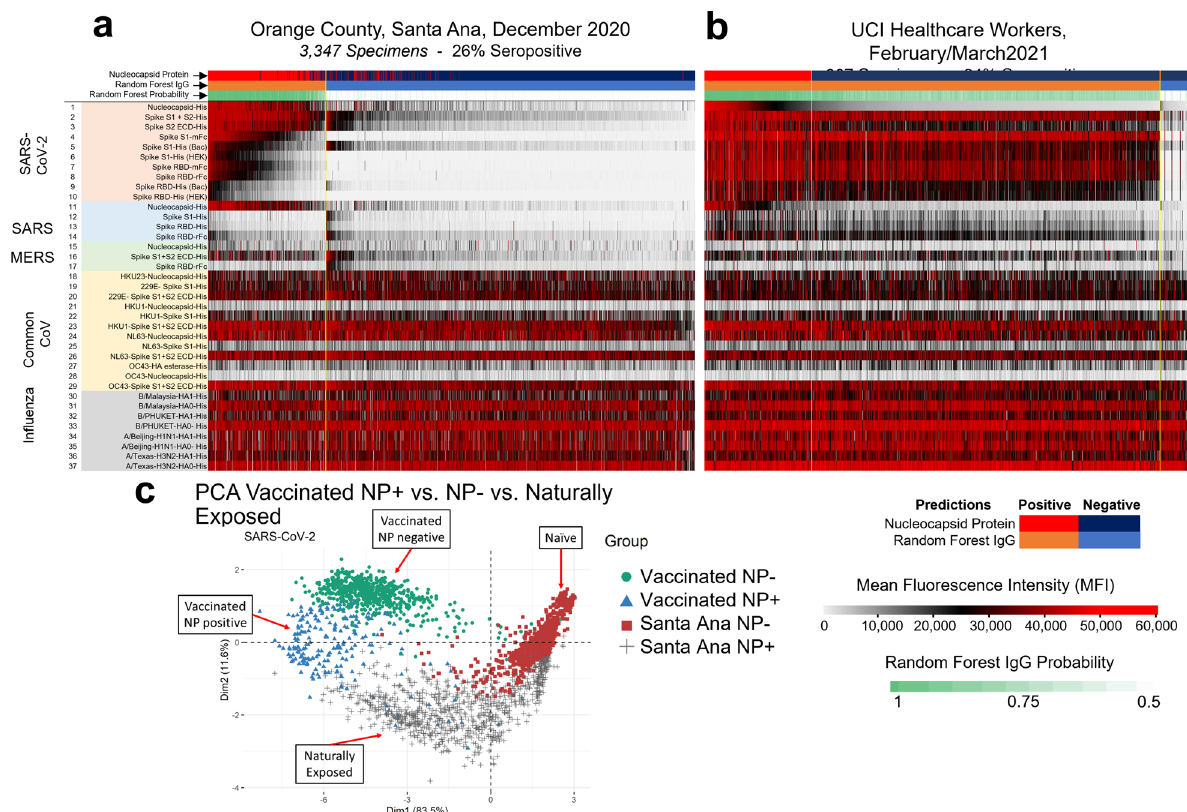
Fig. 3 Antibody reactivity of the Santa Ana and health care workers groups. The heat maps show all of the IgG reactivity data from 3347 pre-vaccination specimens collected from Santa Ana in December 2020 ( a ), and 907 post-vaccination specimens collected from the UCIMC in February ( b ). The 37 antigens are in rows and the specimens are in 3347 columns for ( a ) and 907 columns for ( b ). The level of antibody measured in each specimen against each antigen is recorded as mean fl uorescence intensity (MFI) according to the graduated scale from 0 to 60,000. Red is a high level, white a low level and black is in between. a Samples are classi fi ed as either SARS-CoV-2 seropositive clustered to the left (orange bar) or seronegative and clustered to the right (blue bar). Seropositive specimens recognize nucleoprotein and full-length spike. RBD segments are recognized less well. b Reactivity of specimens from 907 UCIMC HCW, 94% were vaccinated and seropositive. The heatmap shows that seropositive vaccinees in the HCW cohort can be classi fi ed into two groups, either seropositive for nucleoprotein or not, whereas the naturally exposed population ( a ) is uniformly seropositive for both nucleoprotein and full-length spike. c Principal component analysis of the protein microarray data in this study. The specimens fall into 4 distinct groups based on their reactivity against 10 SARS-CoV-2 antigens. Naturally exposed individual separate from unexposed naives, the naturally exposed separate from the vaccinees, and the vaccinees separate into 2 groups depending on whether they are seropositive for NP or